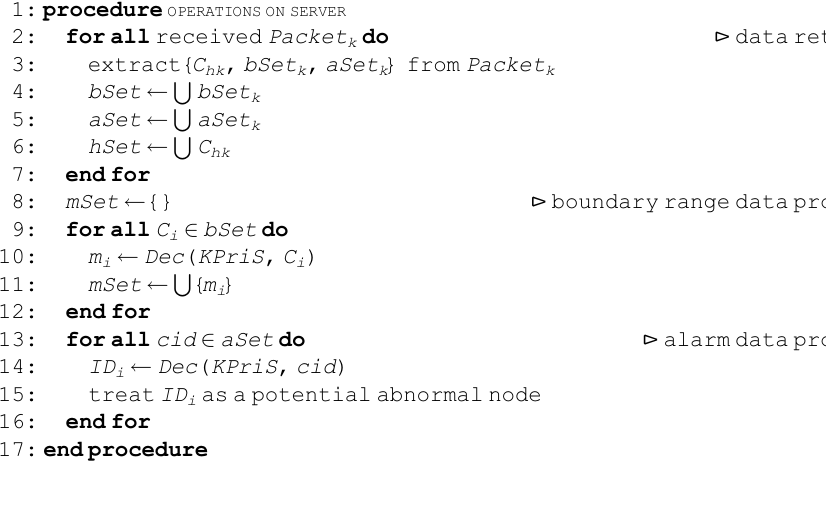
Algorithm 3 Operations on Server (Part